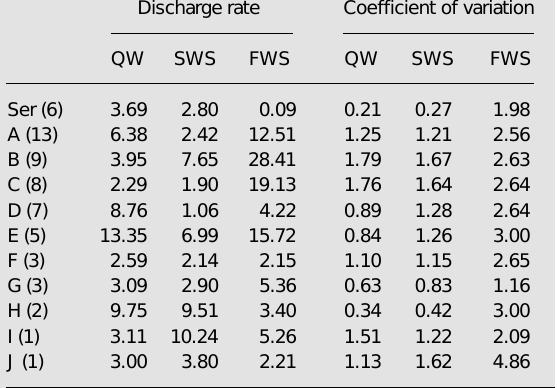
Table 1. Median discharge rate (Hz) and median interspike interval coefficient of variation for quiet waking (QW), slow wave sleep (SWS) and fast wave sleep (FWS) of serotonergic (Ser) and non-serotonergic neurons (A to J). Discharge